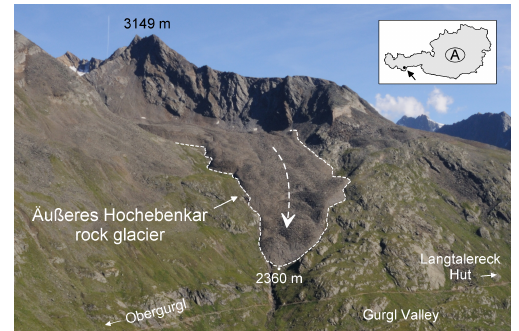
Figure 5. Terrestrial view of Äußeres Hochebenkar rock glacier. The rock glacier is nourished by debris from the surrounding headwalls and moves from a low inclined cirque floor into steeper terrain. Its frontal slope is prone to landsliding. Photograph taken by V. Kaufmann on 10 August 2008.